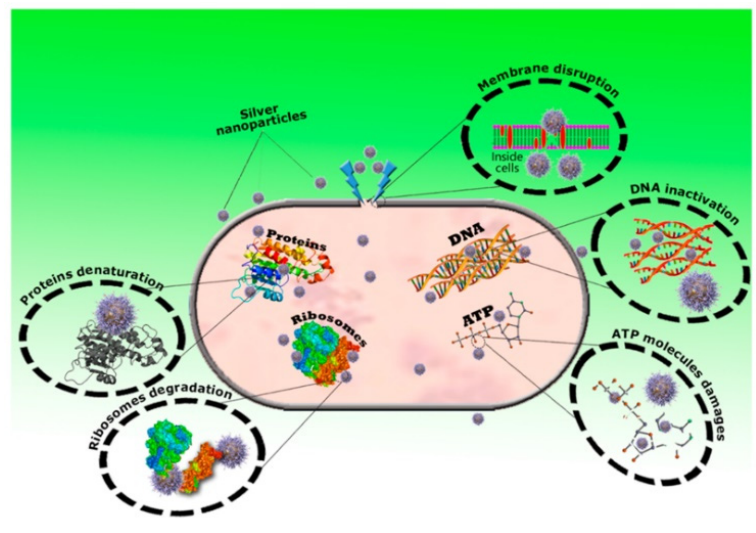
Figure 10. The possible antibacterial mechanism of green-synthesized Ag nanoparticles. Copied from MDPI [208].